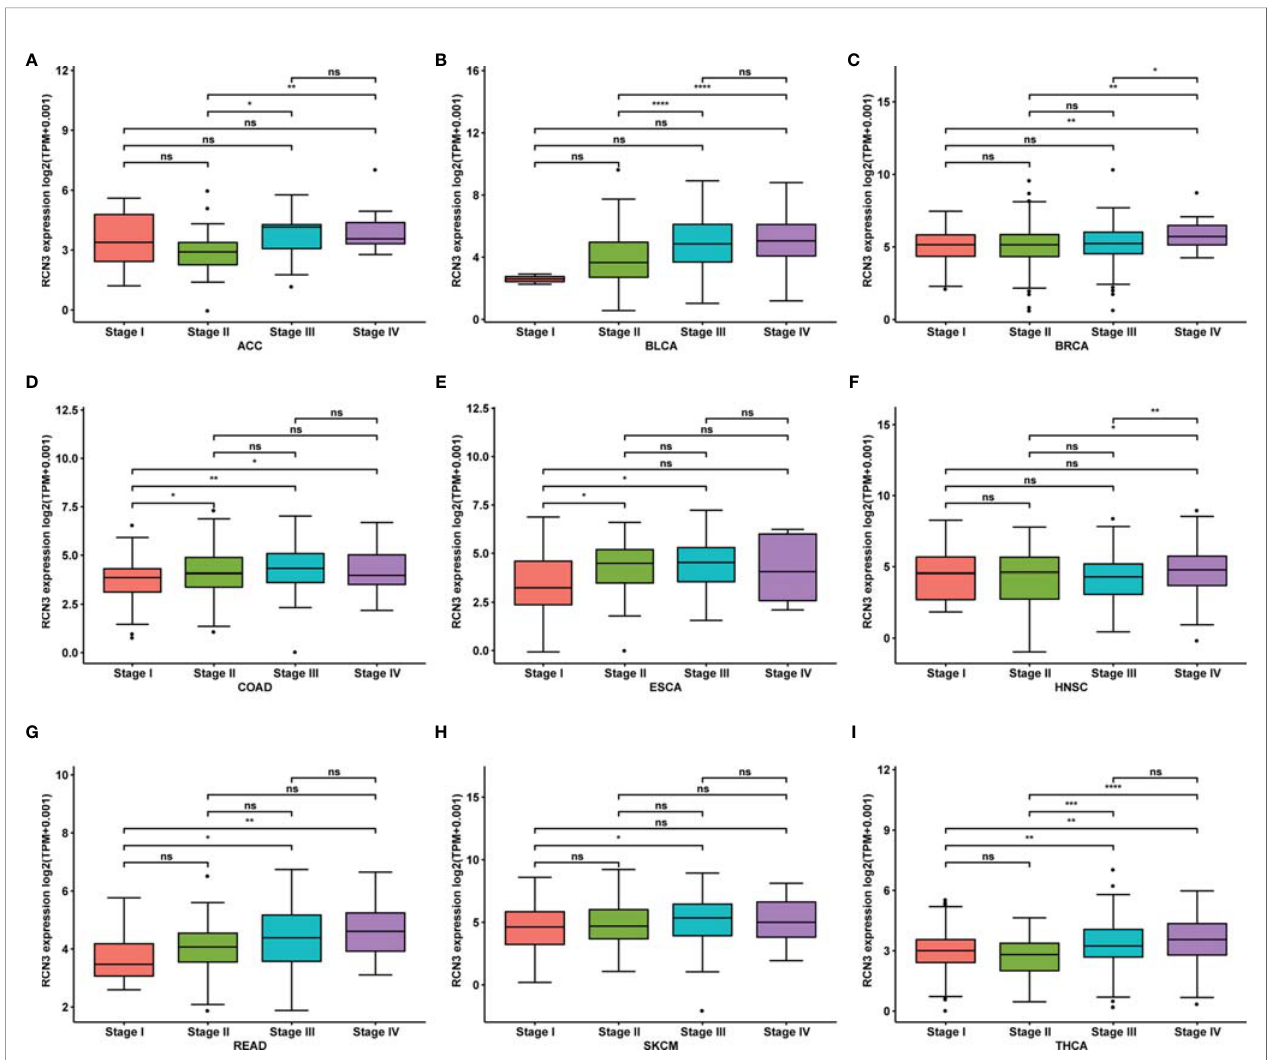
FIGURE 2 | Correlation between RCN3 expression and pathological stages of cancers in TCGA. (A – I) Box plot showing the relationship of different tumor stages with RCN3 expression in different cancers from TCGA. *p < 0.05; **p < 0.01; ***p < 0.001; ****p < 0.0001; ns, no signi fi